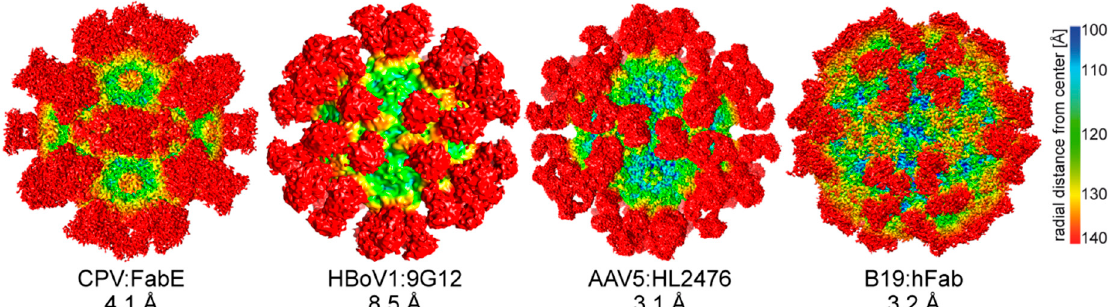
Figure 9. Parvovirinae ‐ antibody complex structures. The highest resolution complex structures available for Protoparvovirus , Bocaparvovirus , Dependoparvovirus , and Erythroparvovirus are shown. The cryo ‐ EM density maps are viewed down the icosahedral 2 ‐ fold axis and are colored according to radial distance from the particle center (blue to red), as indicated by the scale bar. The FAbs decorating the capsid surface are in red. The FAbs bind across the icosahedral 2 ‐ fold (e.g., CPV:FAbE), the 2 ‐ /5 ‐ fold wall (HBoV1:9G12), the 3 ‐ fold (AAV5:HL2476), and 5 ‐ fold depression (B19:hFab). The images were generated using Chimera [78]. (CPV: EMD ‐ 6629, B19: EMD ‐ 9110).